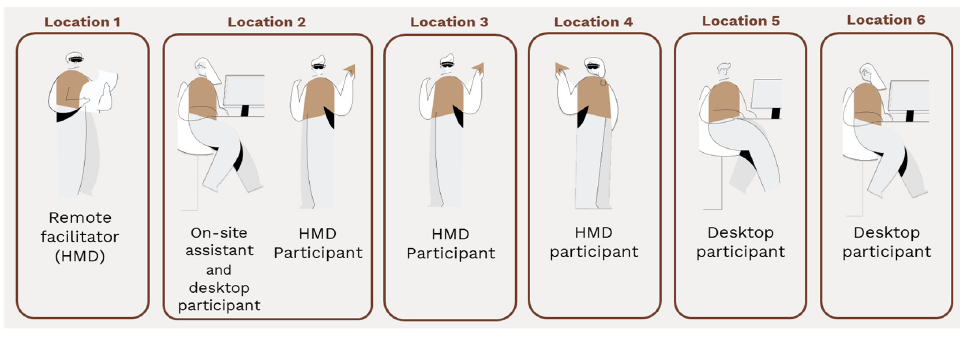
Figure 5. User test setup in Case 2.